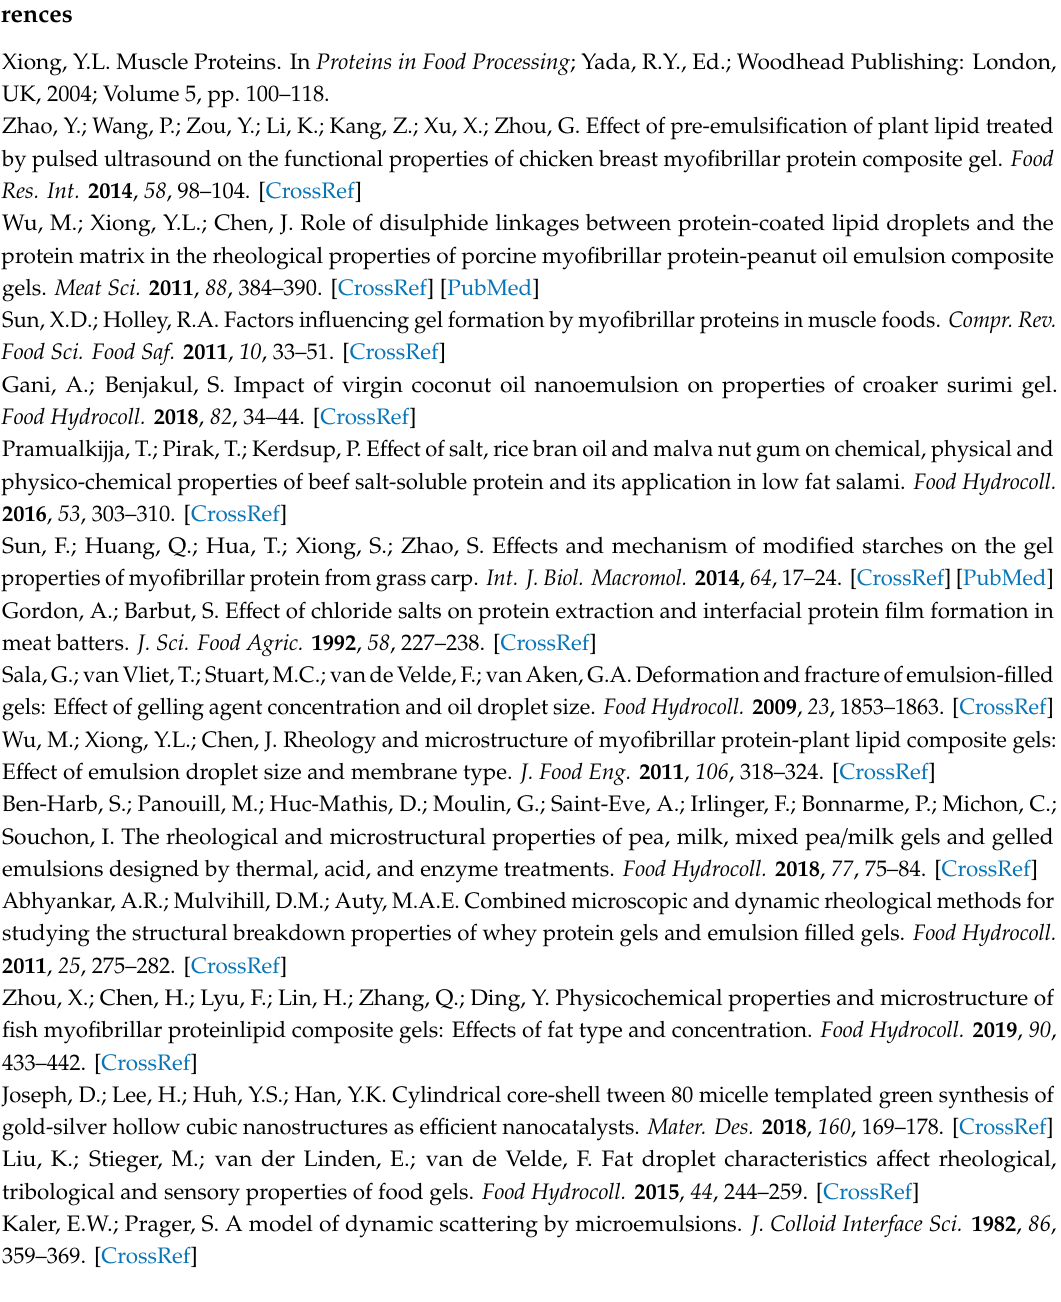
Figure S2: Storage modulus (G (cid:48) ), loss modulus (G”), and tan δ of gels containing MP- or Tween 80-stabilized camellia seed oil emulsions across di ff erent